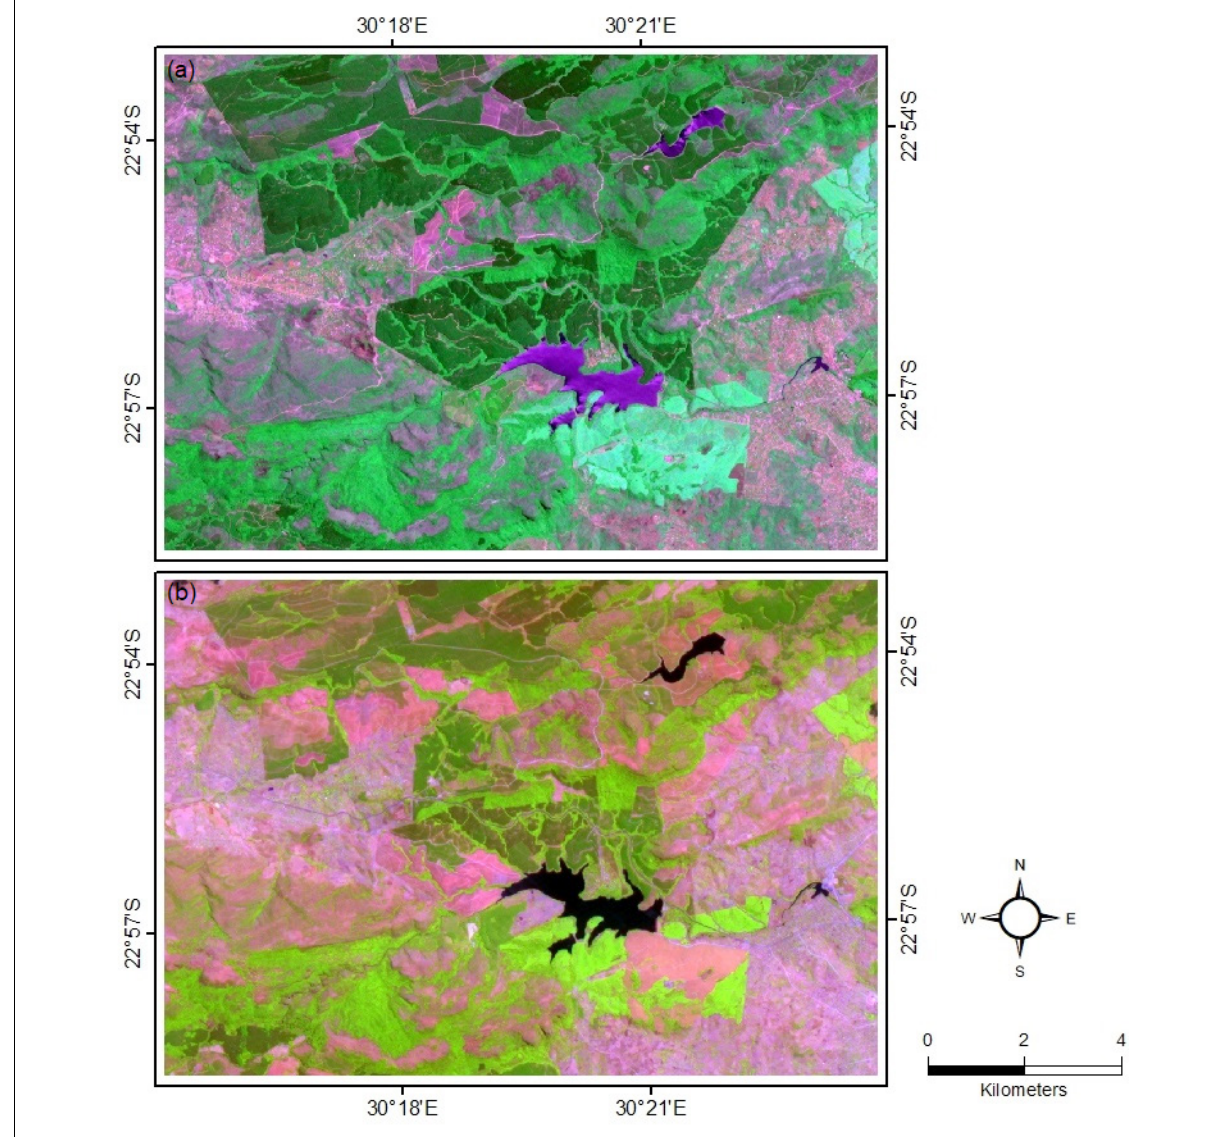
Figure 3: Advanced Spaceborne Thermal Emission and Reflection Radiometer (ASTER) images of the study area acquired in (a) 2017 and (b)